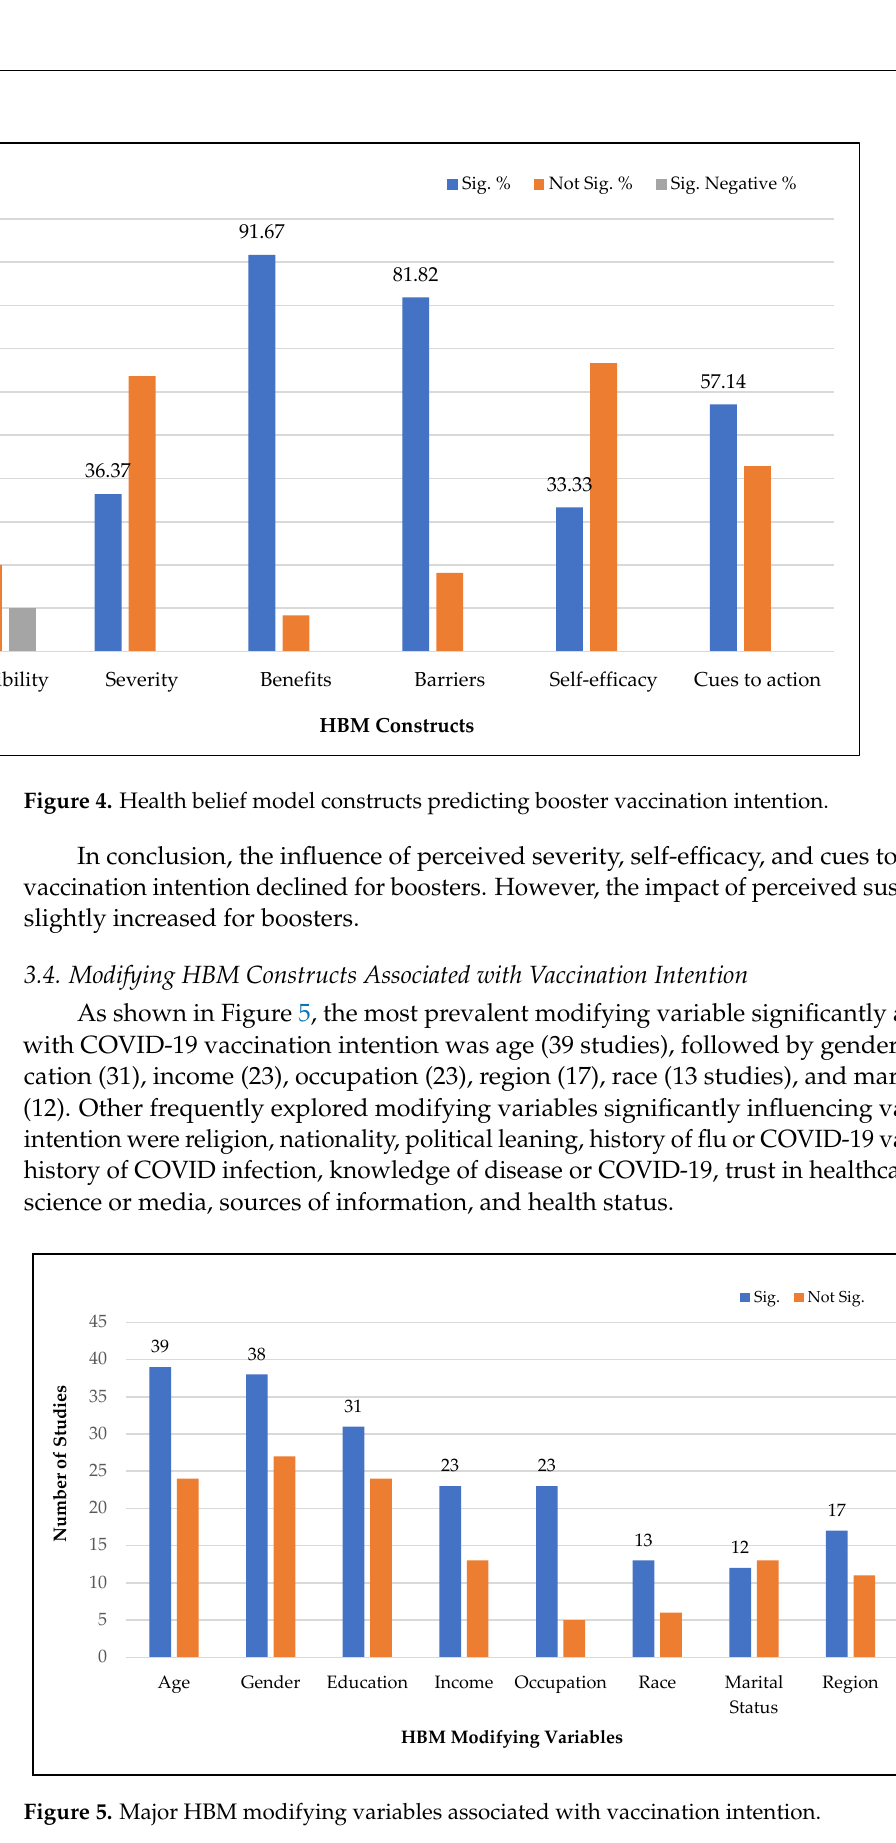
Figure 5. Major HBM modifying variables associated with vaccination